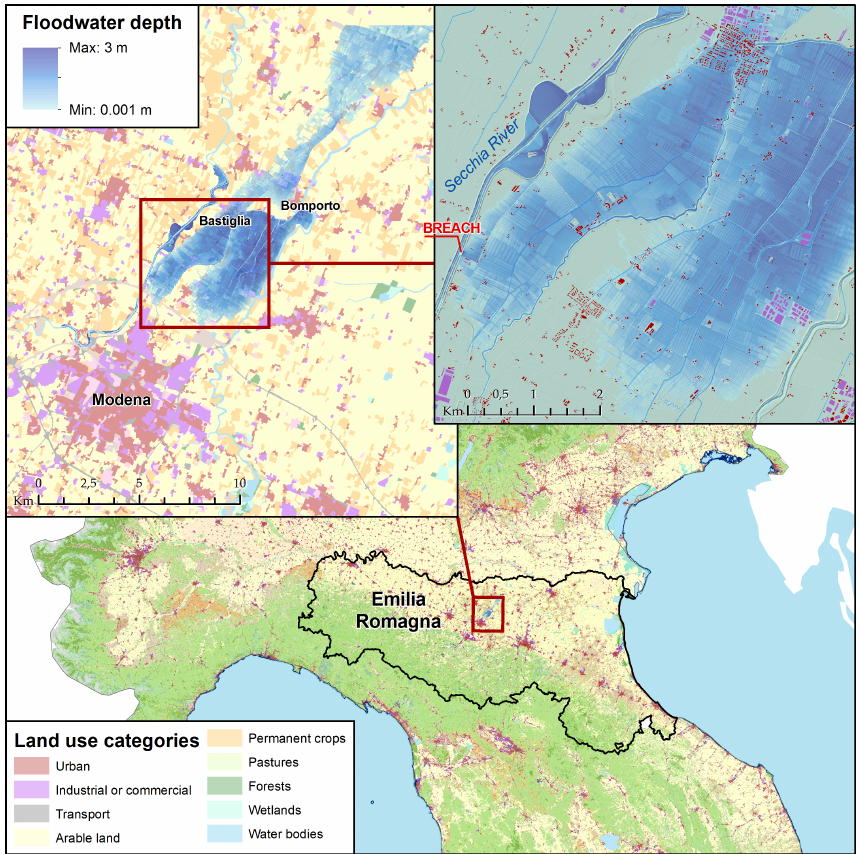
Figure 1. Identification of case study, flooding from the river Secchia during January 2014 in central Emilia-Romagna, northern